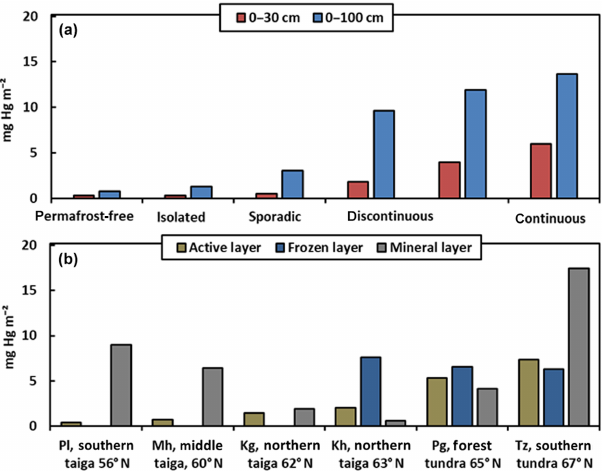
Figure 5. Latitudinal variation in WSL soil Hg storage (mgHgm − 2 ) in the 0–30 and 0–100cm peat layer (a) and in the ac- tive, frozen, and mineral layers (b) . In the permafrost-free zone, the first 40cm were used to calculate Hg storage in the active layer. The permafrost peat layer is fixed from the lower boundary of the active (unfrozen) layer down to 100cm. Finally, for the mineral layer we considered only the first 10cm below peat deposits across the full latitudinal gradient of the WSL peatland.